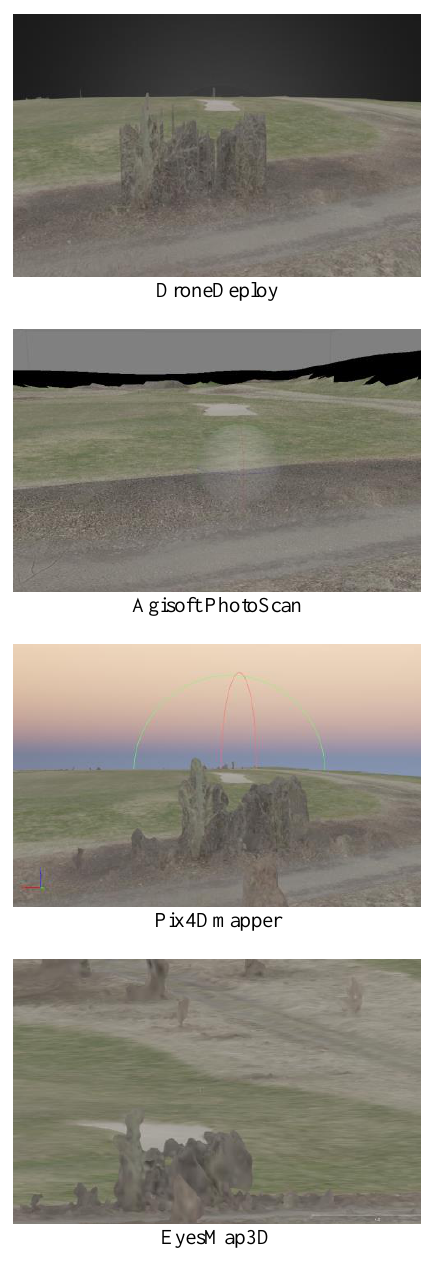
Figure 5. 3D models generated for